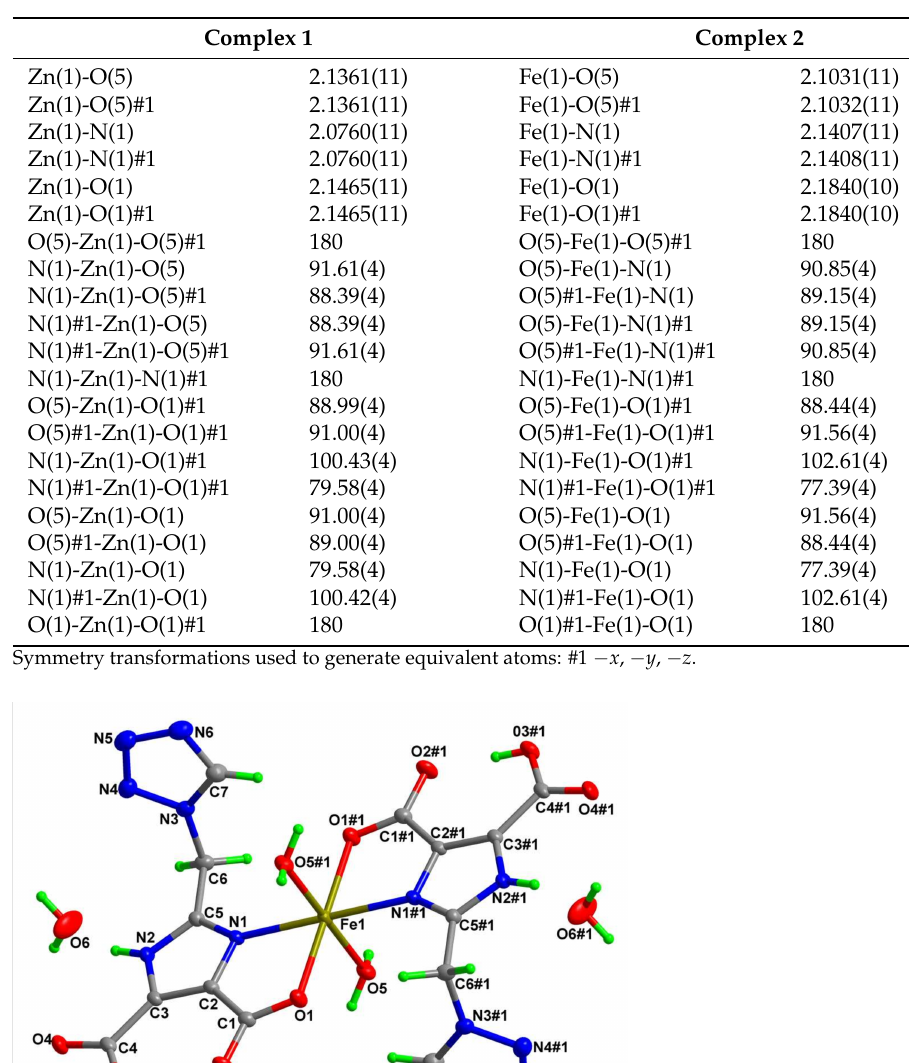
Table 2. Selected bond lengths (Å) and angles ( o ) for complexes 1 and 2 .